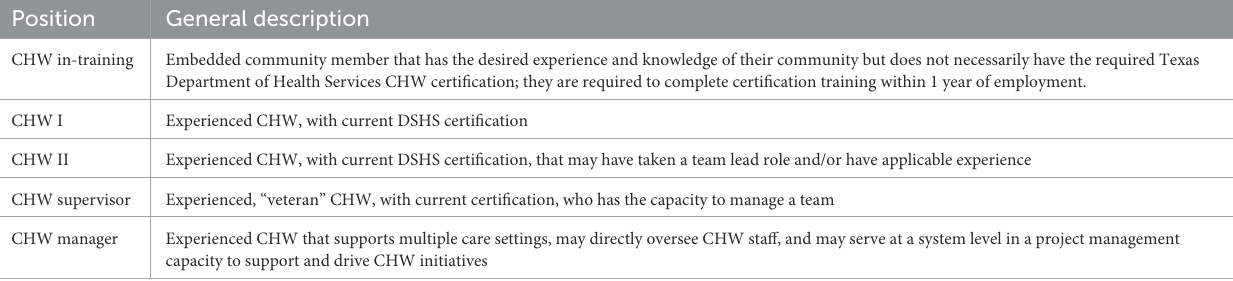
TABLE 6 Baylor Scott & White Health CHW